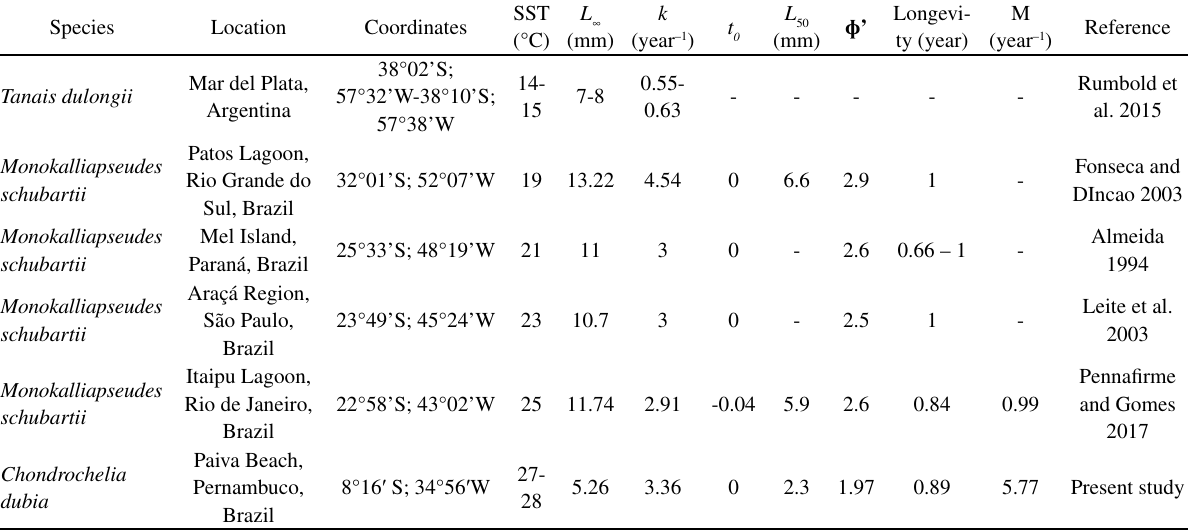
Table 2. – Tanaid species and their respective von Bertallanfy population growth parameters estimated in previous studies from the southwestern Atlantic. M, natural mortality; SST, sea surface temperature (mean) (Boyer et al. 2018).